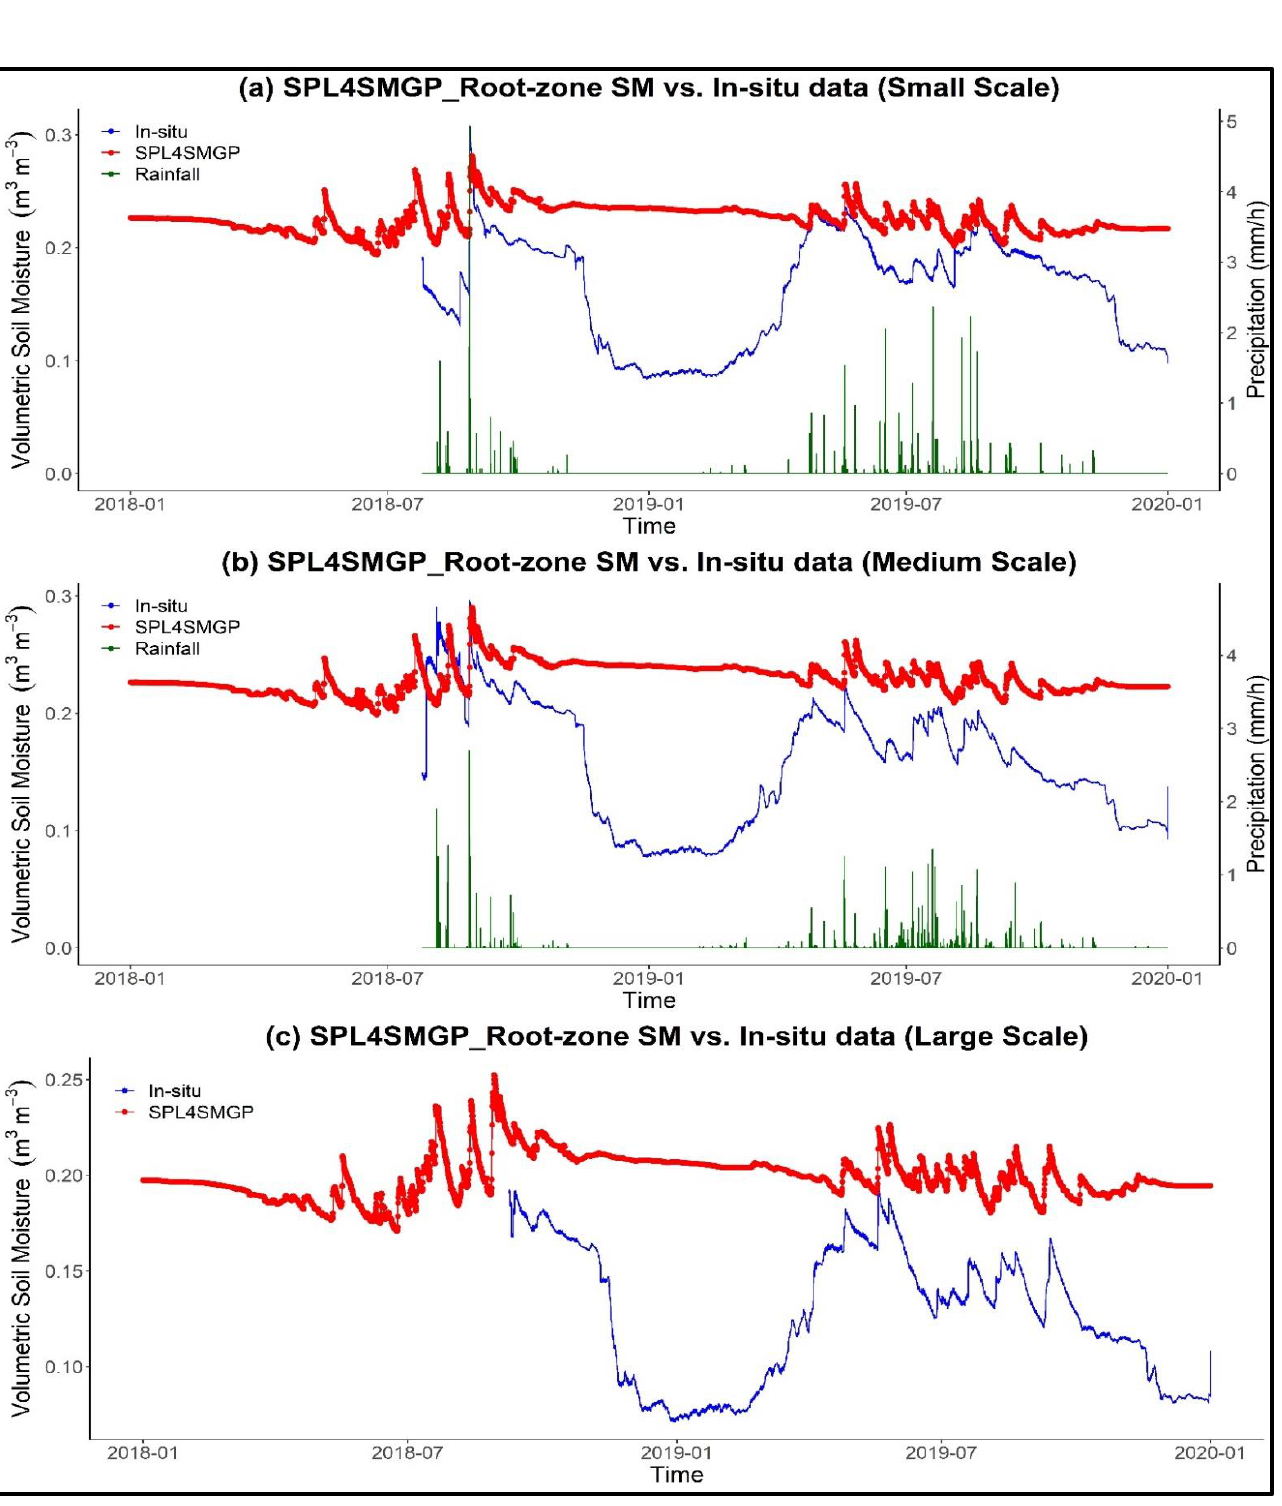
Figure 3. Time series evaluation of SPL4SMGP RZSM and station averaged in situ SM at different spatial locations, ( a ) S-scale stations, ( b ) M-scale stations, ( c ) L-scale stations. The SPL4SMGP SSM estimates were underestimated with a bias of − 0.026 m 3 /m 3 rel- ative to the in situ SM. In contrast, SPL4SMGP RZSM retrievals had a positive bias of 0.033 m 3 /m 3 , indicating an overestimation compared to the in situ observations. The RMSE val- ues are 0.051 m 3 /m 3 and 0.038 m 3 /m 3 for the SSM and RZSM datasets, respectively. Af- ter removing their respective biases from RMSE, a moderate to good accuracy was ob- tained, with ubRMSE values of 0.044 m 3 /m 3 with a standard deviation value of 0.052